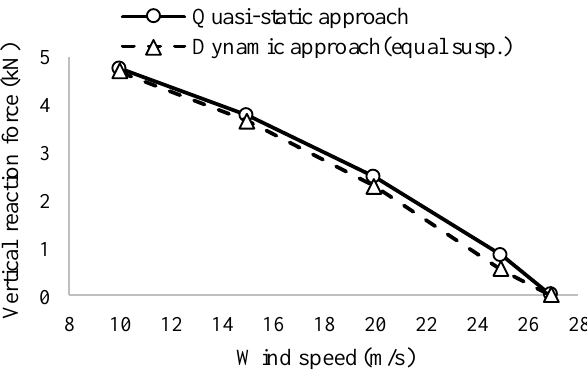
Figure 8. Windward vertical reaction force of the van with equal stiffness of suspension in front and rear axles.